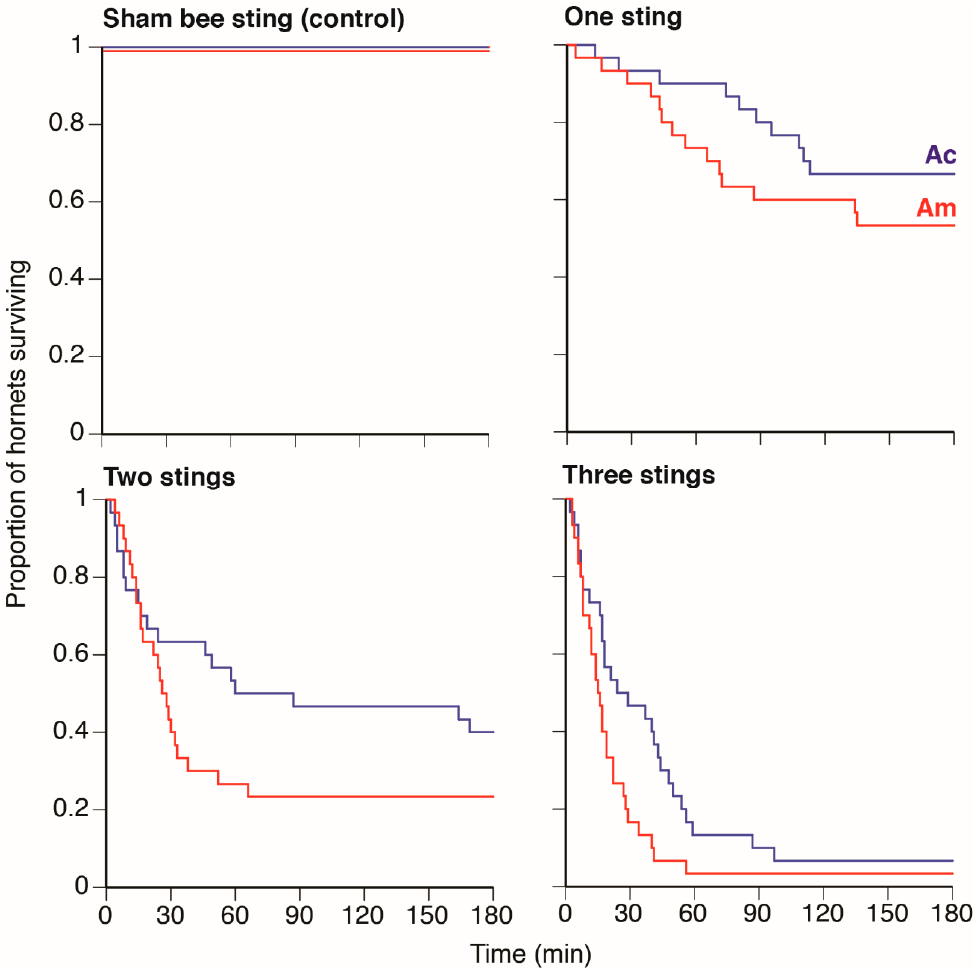
Figure 2. Effects of different numbers of bee stings from A. cerana (Ac) or A. mellifera guards (Am) on hornet survival over time. In the sham bee sting treatment, hornets were randomly assigned a priori as Ac or Am sham treatments and all survived (colored lines are slightly offset to facilitate visualization).